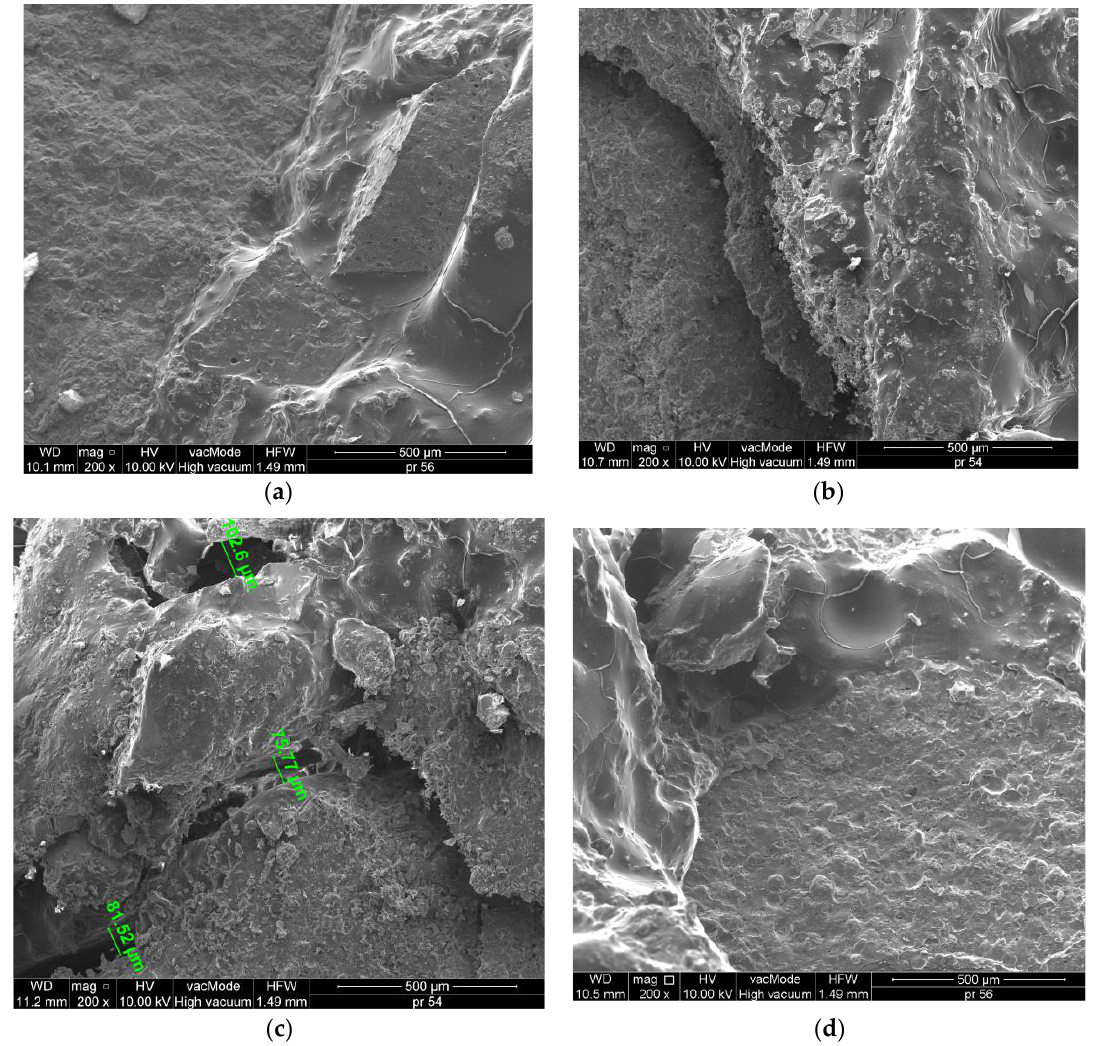
Figure 8. Micro-structure of MAM: ( a ) WC-1 dolomite + ceramics 0/4, ( b ) WC-2 dolomite + ceramics, ( c ) WC-3 granodiorite + ceramics, ( d ) WC-4 dolomite (×200).